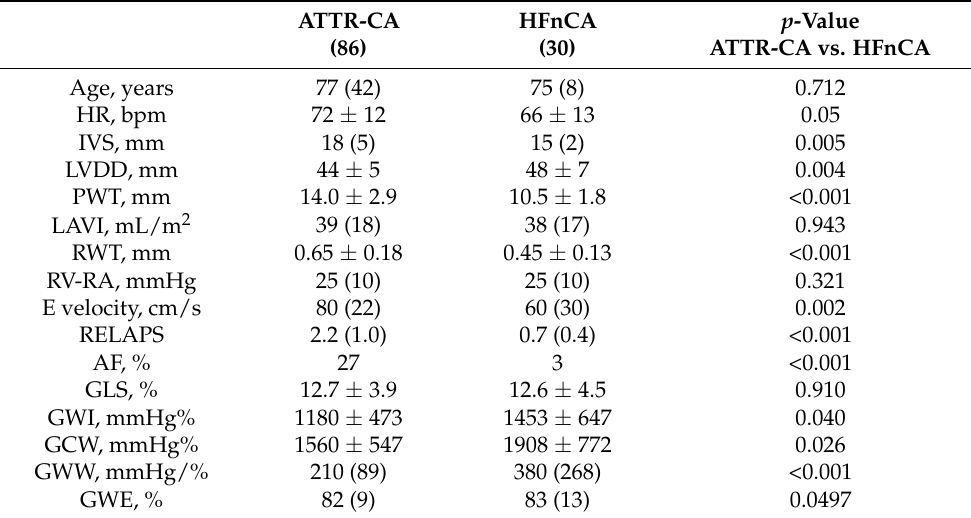
Table 2. Echocardiographic data in ATTR-CA and HFnCA in all patients.